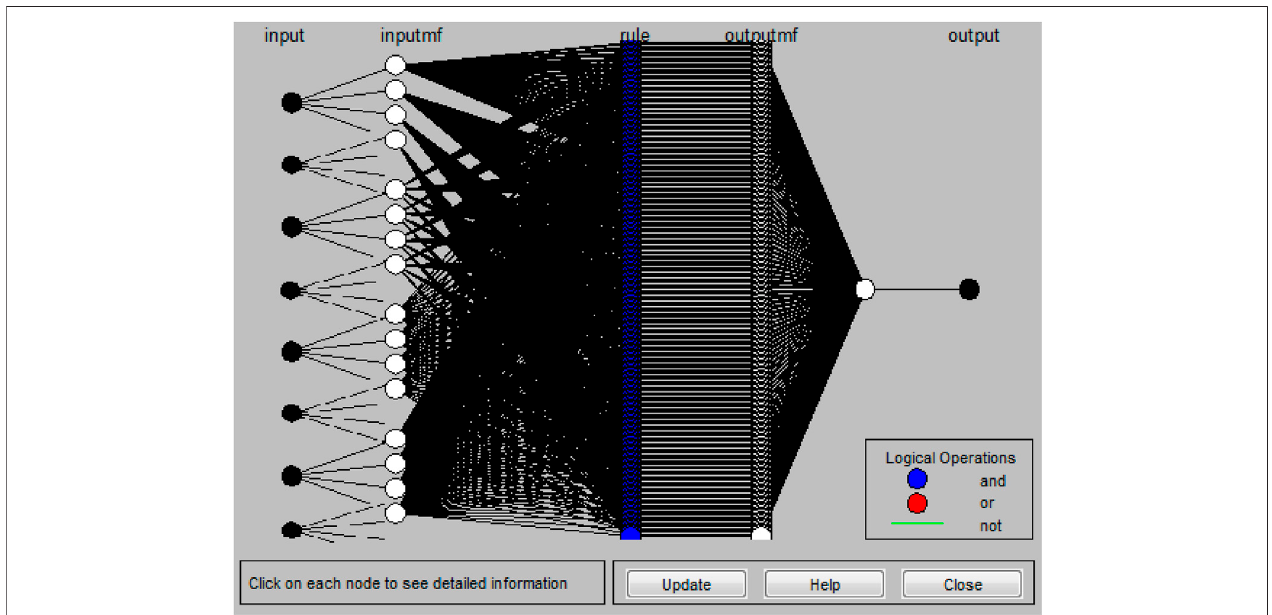
FIGURE 2 | ANFIS model structure.